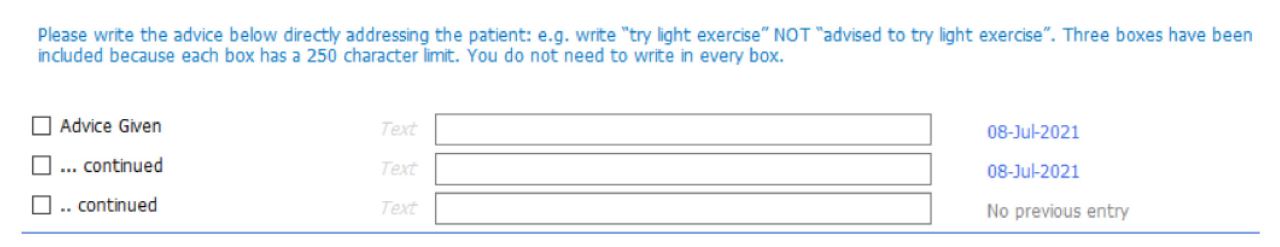
Figure 6. Summary report EMIS template – general advice section (1).